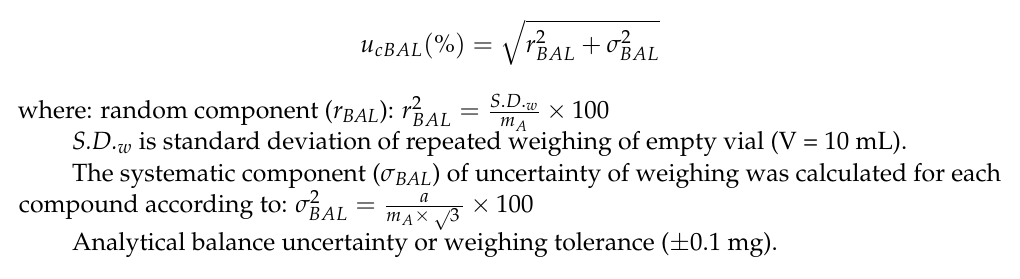
Tables S7 and S8: Standard deviation STDEV on measured solubilities of 1-hexene (1)/toluene (2) mixture with DES #3 (3) for mole fractions x: Top layer and bottom layer. Tables S9–S11: GC data of top and bottom layers for 1-hexene (1)/toluene (2) mixture with DES #i (3). Table S12: Summary of performance extraction of toluene/heptane using organic solvents and ILs. Tables S13–S15: Composi- tion of the NRTL tie-lines (mole fraction), for the ternary system {1-hexene (1) + toluene (2) + DES